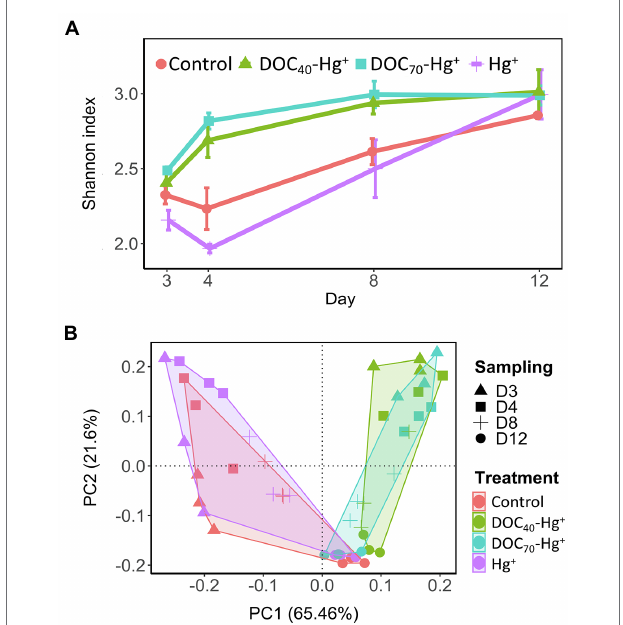
FIGURE 4 | Diversity (Shannon’s index at genus level) (A) and community structure (B) of bacterial communities from the different treatments over the experiment. Error bar represent the standard error ( n =